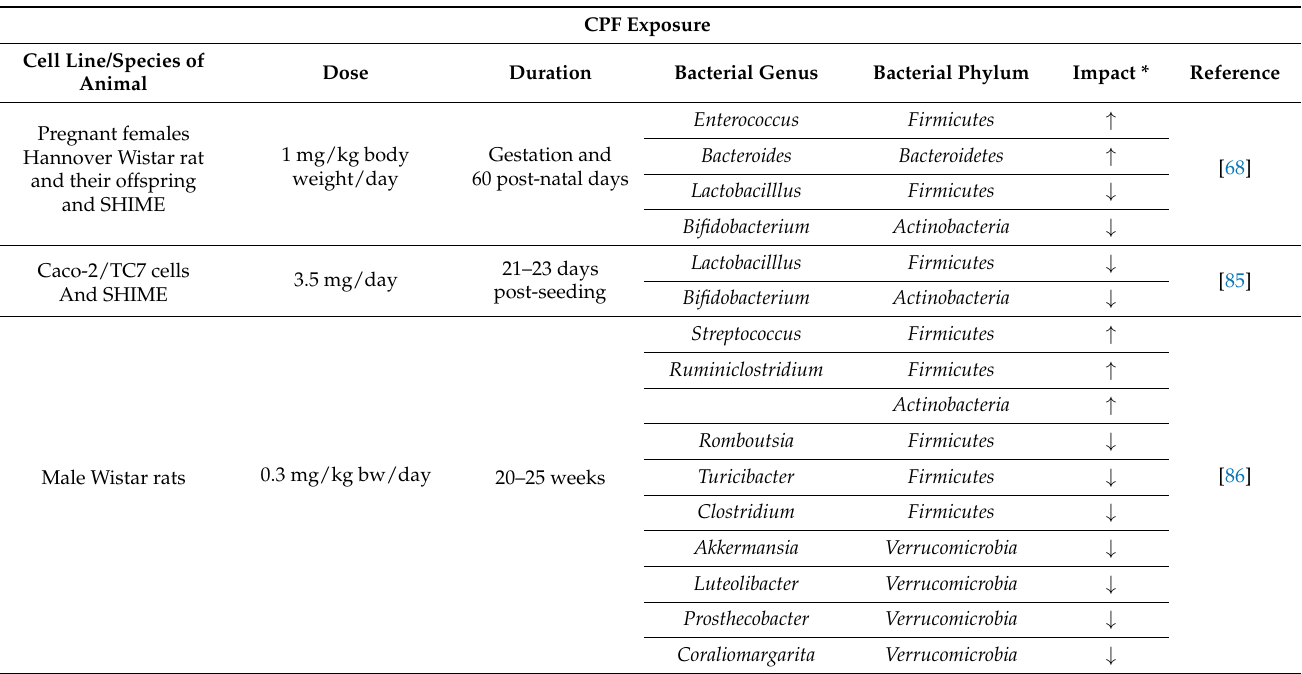
Table 2. Studies on exposure to CPF and its relationship with the intestinal microbiota. CPF